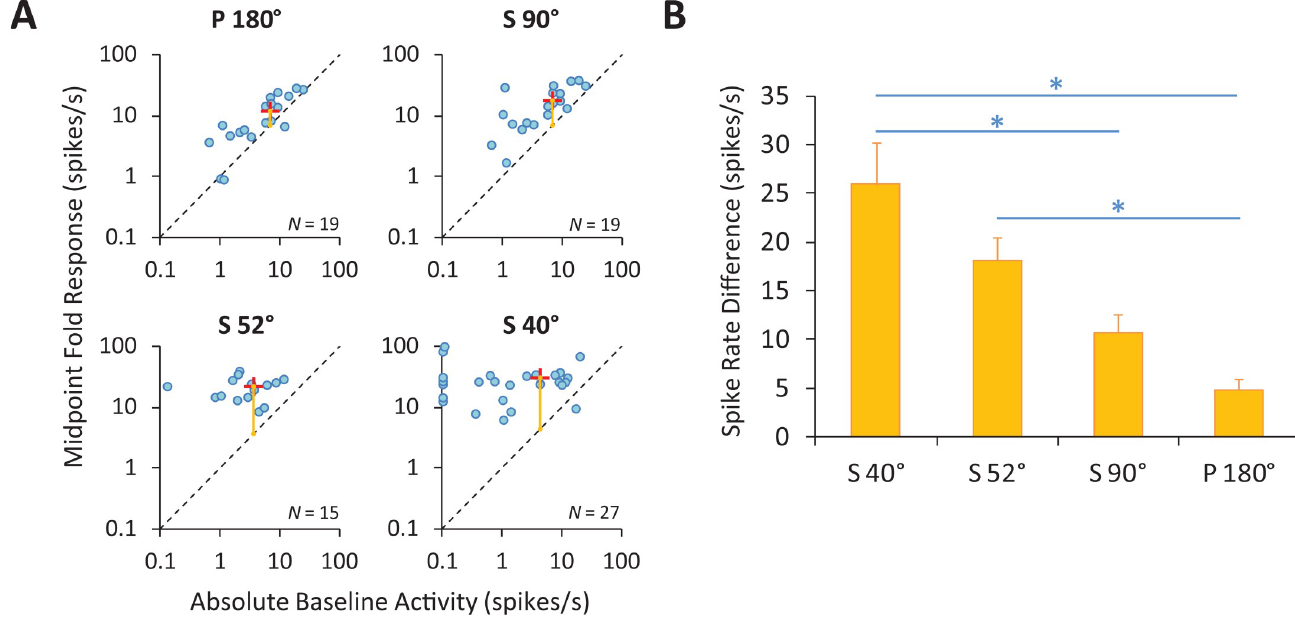
Fig 4. Neural responses to corner-folds depend on corner angle. (A) Population data of midpoint corner-fold responses versus absolute baseline activity. Blue points represent responses from individual V1 neurons to corner-folds of three different angles (S90˚, S52˚ and S40˚) and to the non-corner gradient (P180˚). P180˚ and S90˚ were in the Square and Edge stimulus ( N = 25), S52˚ was in the Star stimulus ( N = 30), and S40˚ was in the Corners stimulus ( N = 28). The midpoint fold response and absolute baseline activity of each neuron yields the ordinate and abscissa in logarithmic scale of each data point in the scatter plot. The dotted line of unit slope indicates equality between midpoint fold response and absolute baseline activity. The red cross is the mass center of data points. For all folds, most data points and all mass centers fall above the line, indicating a predominance of elevation of midpoint fold response above absolute baseline activity. Furthermore, the length of the yellow vertical line from the mass center to the dotted line of unit slope indicates the average spike rate difference, i.e. the difference: midpoint fold response–absolute baseline activity. The smaller the fold angle, the longer the vertical line, indicating stronger increase of midpoint fold response. (B) Spike rate difference for each of the fold responses. As in (A), the average spike rate difference decreases with increasing fold angle. Error bars represent the SEM. � indicates a significant difference (Wilcoxon rank sum test corrected for multiple comparisons with the Benjamini and Hochberg method [18]) between responses ( � p < 0.05; �� p < 0.01; ��� p < 0.001; see S1 Table for exact p -values).